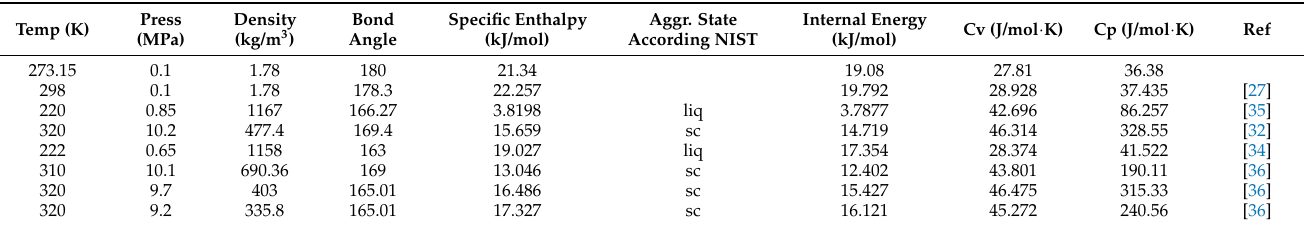
Table 1. Bond-angle values at different temperature, pressure and density conditions. Specific Enthalpy, Internal Energy, Cv and Cp have been calculated using NIST facility after [27,32,34–36].